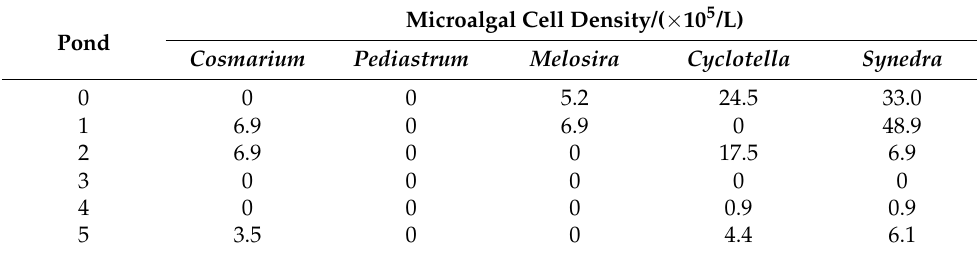
Table A2. Typical types and average densities of microalgal cells in each pond in the summer of the third experimental year